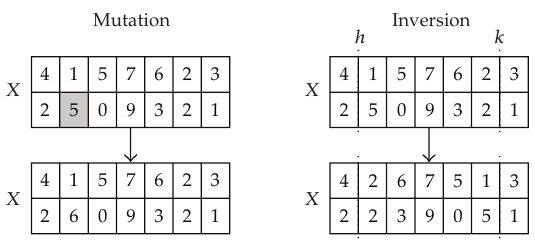
Figure 7: Examples of